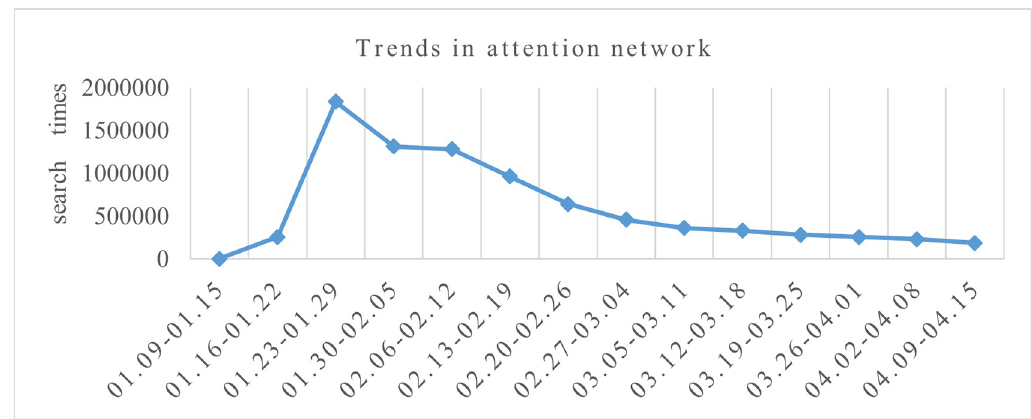
Fig 1. Trend of new coronavirus network attention in